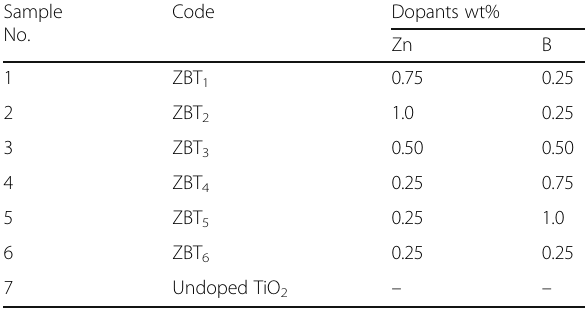
Table 1 Name assigned to different weight percentage of TiO 2 co-doped catalysts Sample